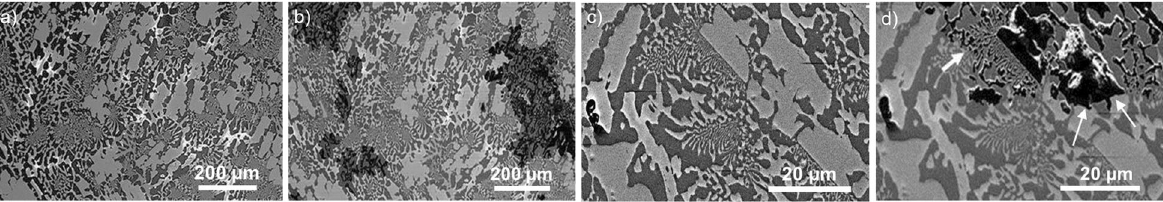
Fig. 5 SEM micrographs of RAW-4 after the PD scan in acidic brine solution. Showing results for low magni fi cation images a before and b after the PD scan and high magni fi cation images c before and d after the PD scan; arrows point to the localized corrosion. The scale bars on the lower magni fi cation images is 200 µm and for the higher magni fi cation images is 20